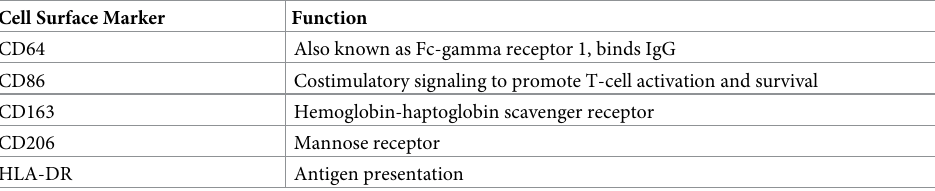
Table 2. Function of cell surface markers selected for flow